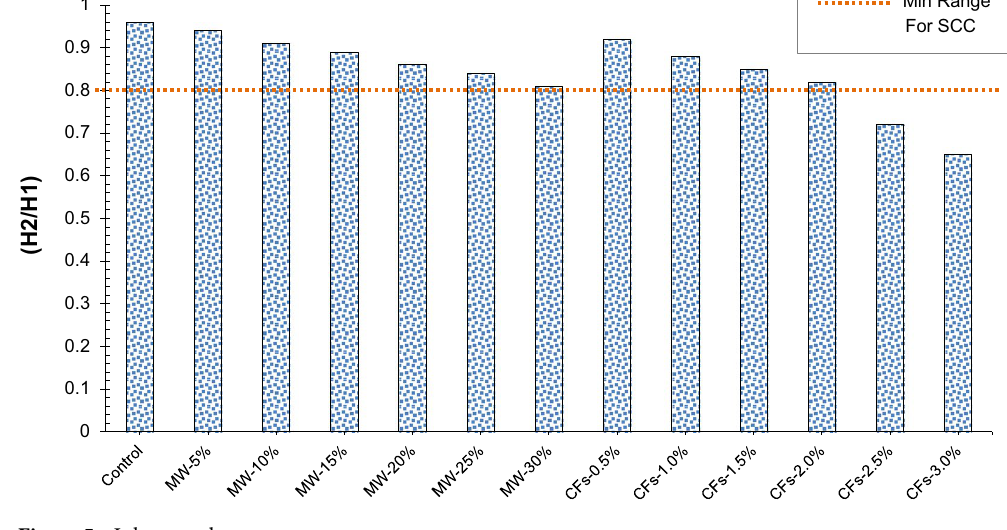
Figure 5. L-box results.